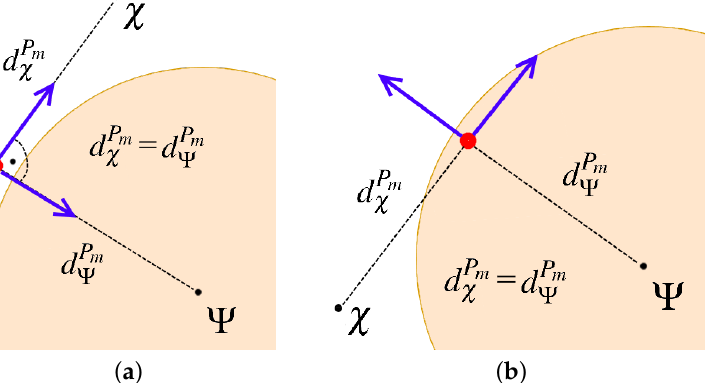
Figure 4. The location of the point χ : ( a ) D P cloud. The artificial potential forces V P m Ψ and V P m χ —blue